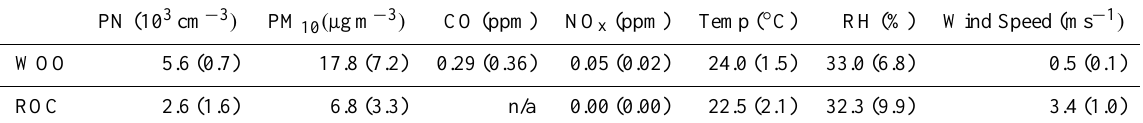
Table 3b. Average values of measured parameters of WOO and ROC from 08:00–16:00 on 9 Sep 2009. A standard deviation showed in bracket.